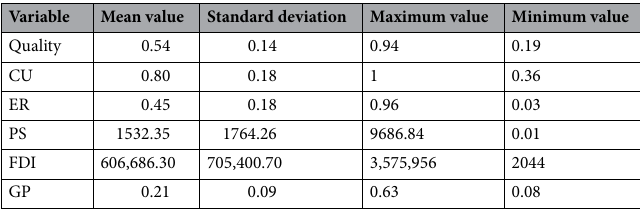
Table 2. Descriptive statistics of